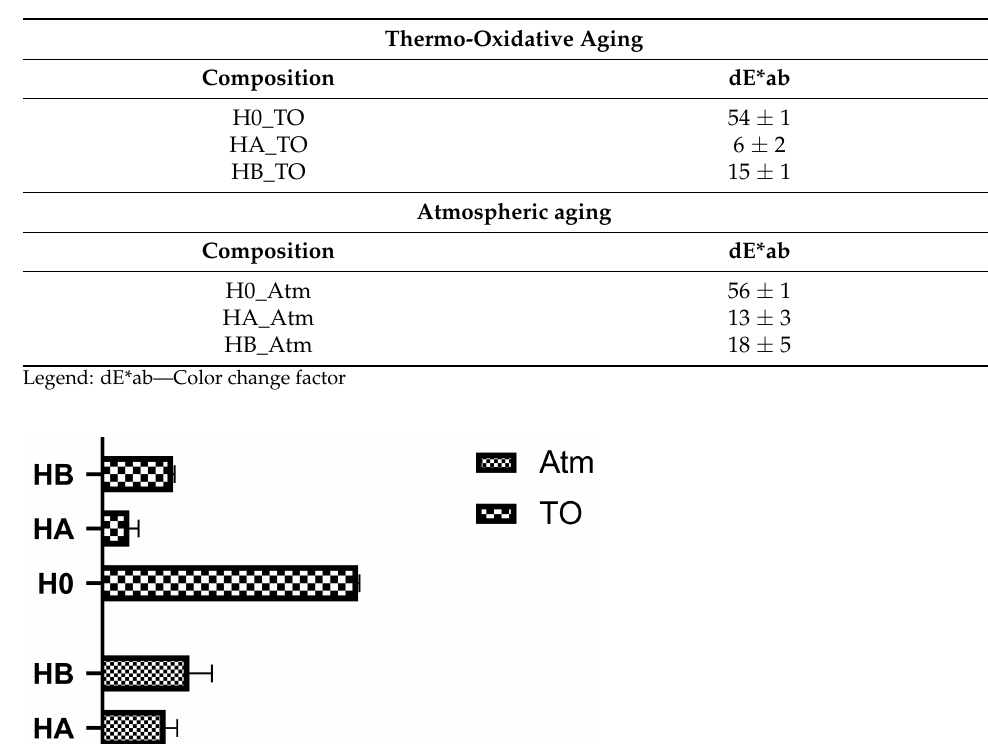
Table 9. Color changes of samples after aging.